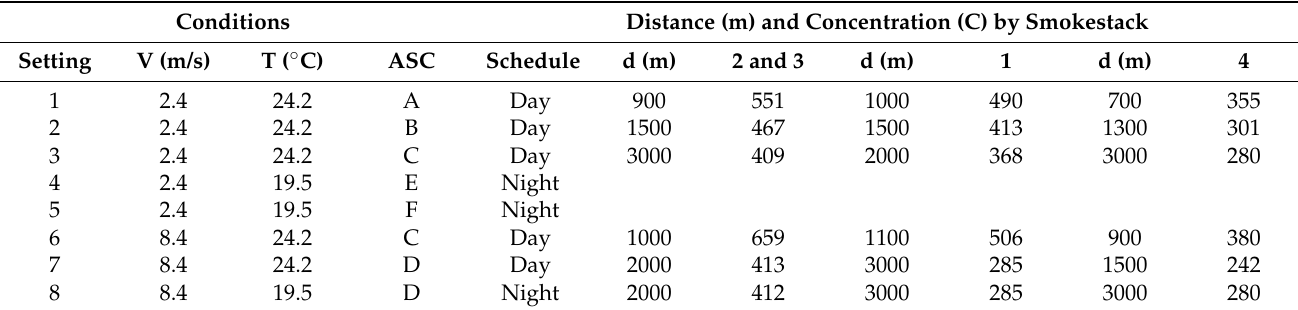
Figure 10. ( a ) Scenary 7 and ( b ) scenery 8. Source: Author’s own elaboration. Table 9. Profile of the maximum SO 2 concentrations at a distance (d) from the emission